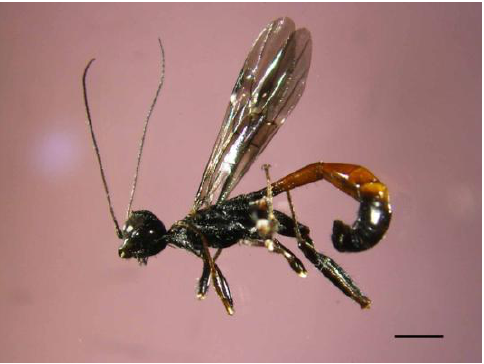
Figure 10. A native stephanid wasp, Stephanus serrator (a male), a likely parasitoid of X. chinensis larvae (see text for details). Scale bar 2 mm. (Photo V. Sarto i Monteys).